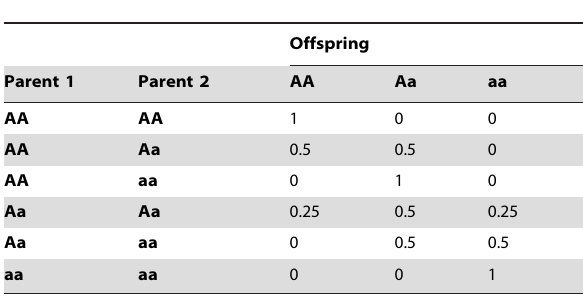
Table 1. Expected genotype